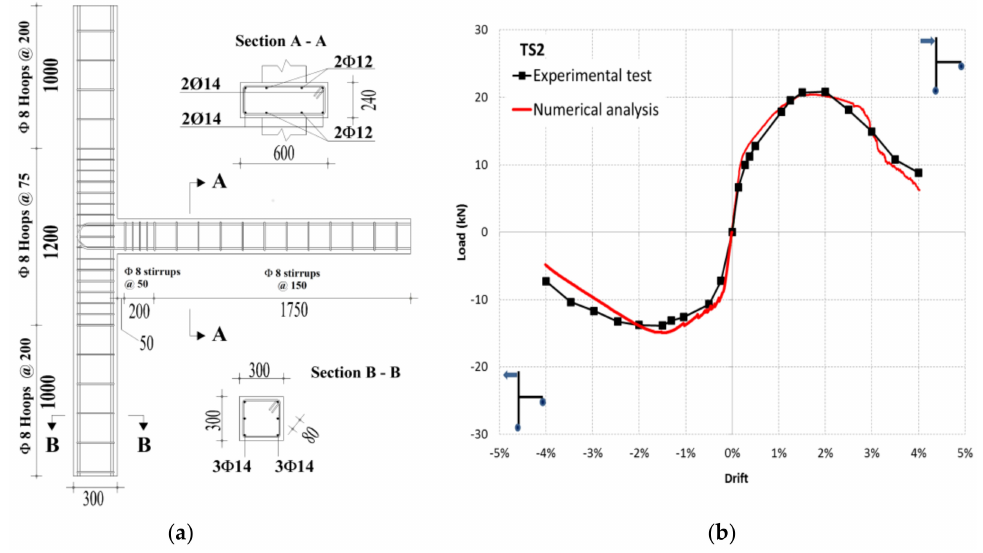
Figure 1. ( a ) Specimen geometry and detailing; ( b ) experimental and numerical load vs. drift